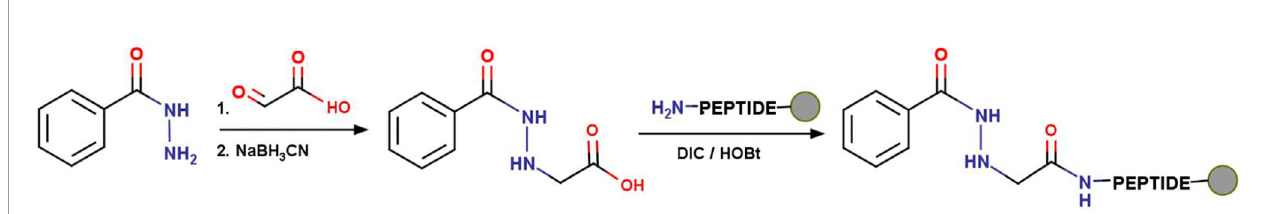
FIGURE 3 | Coupling of isoniazid to peptides. First, INH was derivatized by glyoxylic acid, then reduced with NaBH 3 CN. The corresponding carboxylate was coupled to the peptides on solid phase using DIC/HOBt coupling reagents.